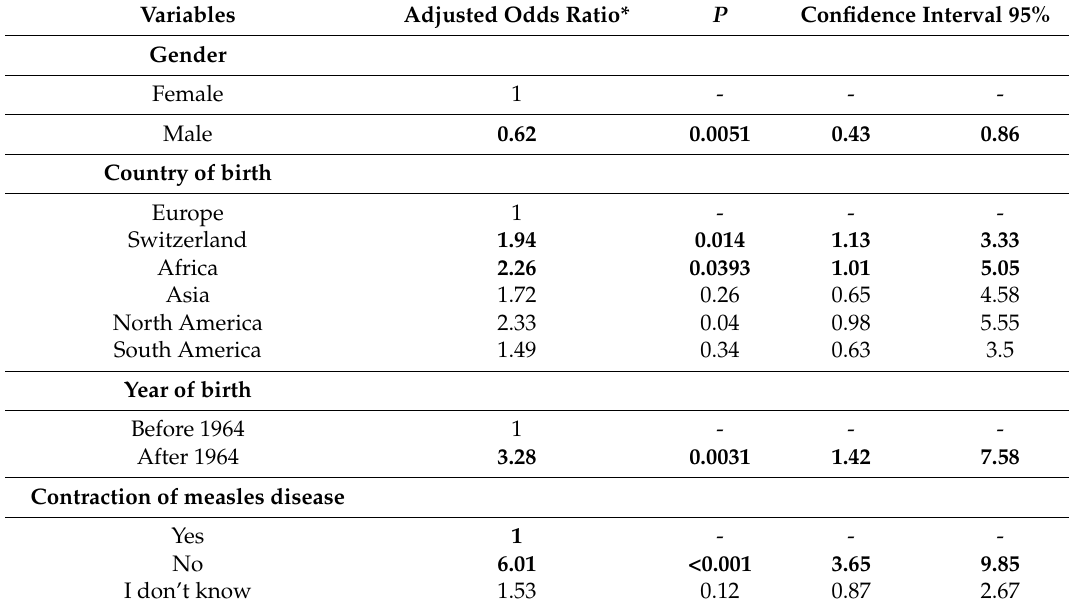
Table 2. Predictive factors of measles immunization: multivariate analysis by logistic regression.